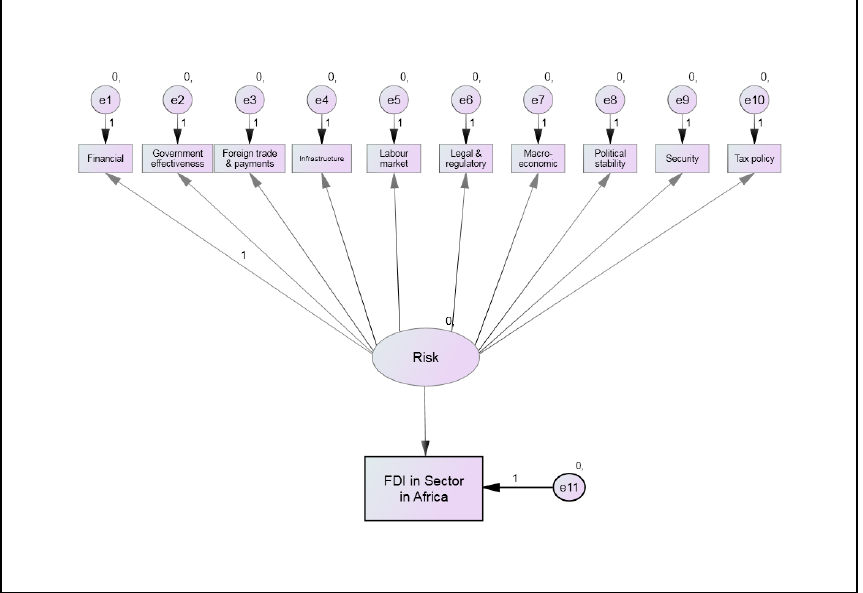
FIGURE 3: Structural equation model specification Source: Own specification based on theoretical